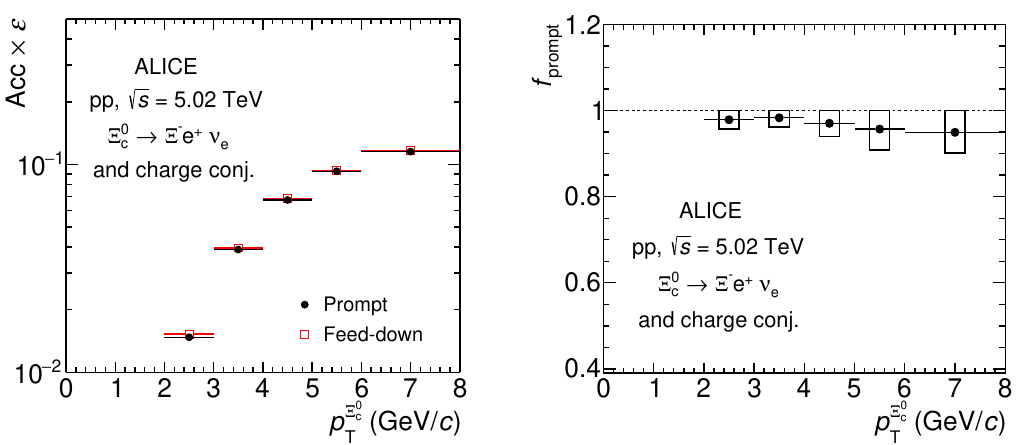
baryons in c baryons in the c